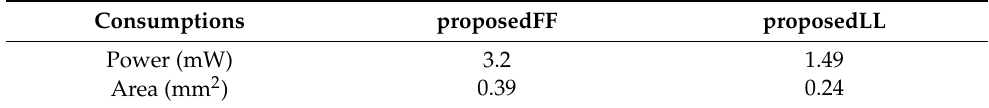
Table 4. Post-physical synthesis consumptions of 1024-channels version: a flip-flop-based memory implementation ( proposedFF ) and a RAM latch-based proposal ( proposedLL